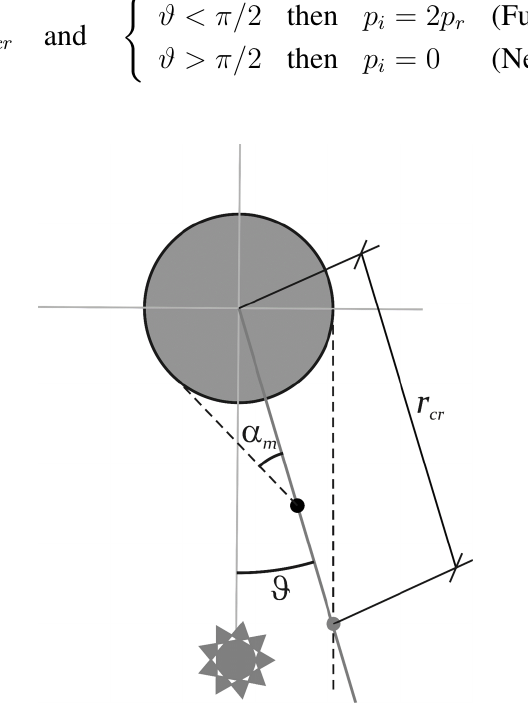
Figure 3. Full/new Moon